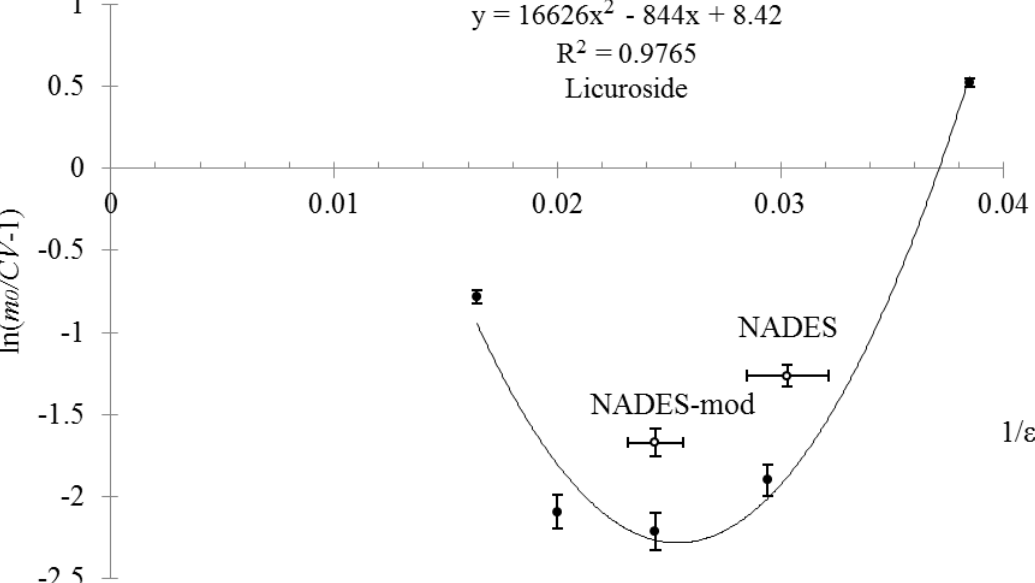
Figure 2. Dependency between licuroside concentration in the extracts and the dielectric constant of sorbitol-based solvents and NADESs in coordinates predicted by the theory.